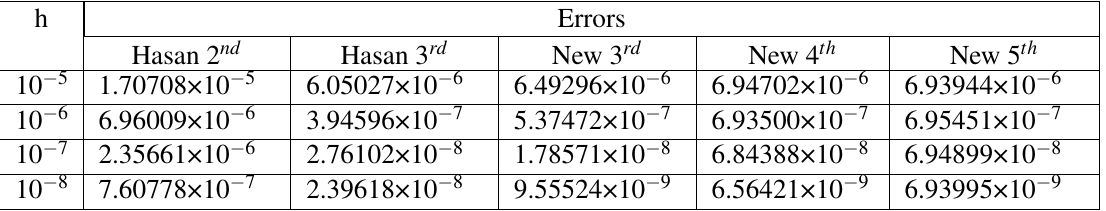
Table 4.1 (c): Absolute errors of the solution of Eq. (21) at x = 0 . 0001 by Hasan’s [13, 16] methods and new methods with Romberg